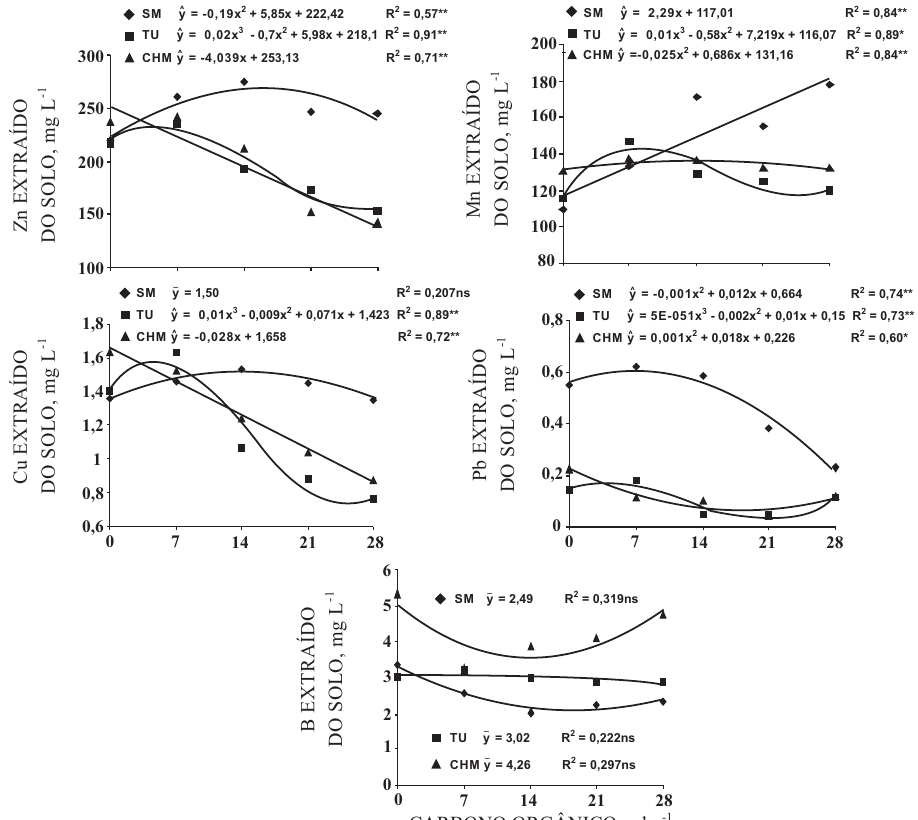
Figura 2. Teores de zinco, cobre, manganês, chumbo e boro extraídos por CaCl carbono orgânico aplicadas via solomax (SM), turfa (TU) e concentrado húmico mineral (CHM). (ns) não-significativo. (**) e (*) significativos a 1 e 5 %, respectivamente.